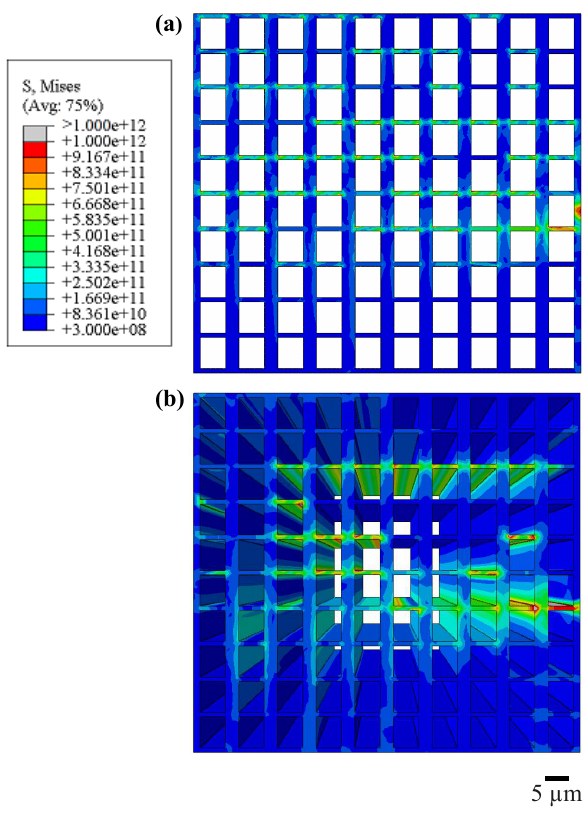
Figure 8. (a) 2-D vs. (b) 3-D comparison of the Lithothamnion glaciale structure based on Ragazzola et al. (2012) measurements. Units =